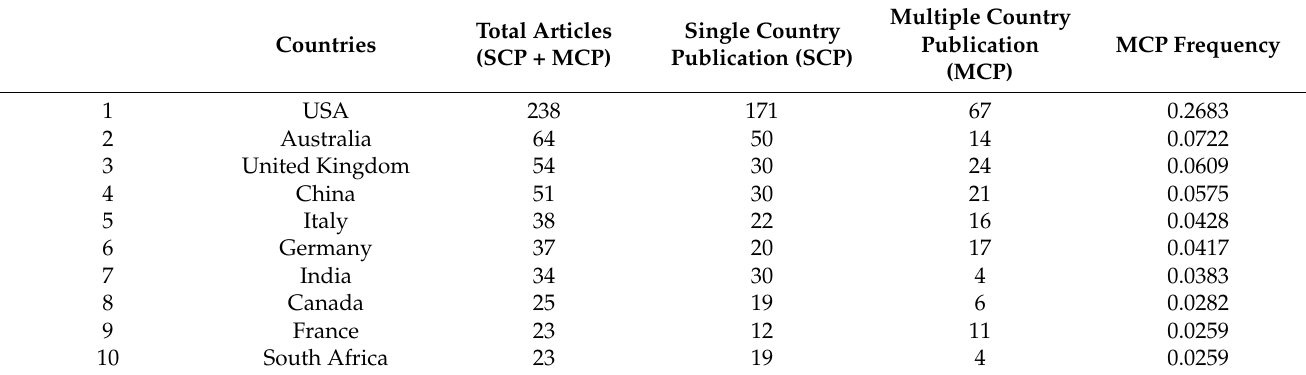
Table 7. Classification of corresponding author’s country and scientific